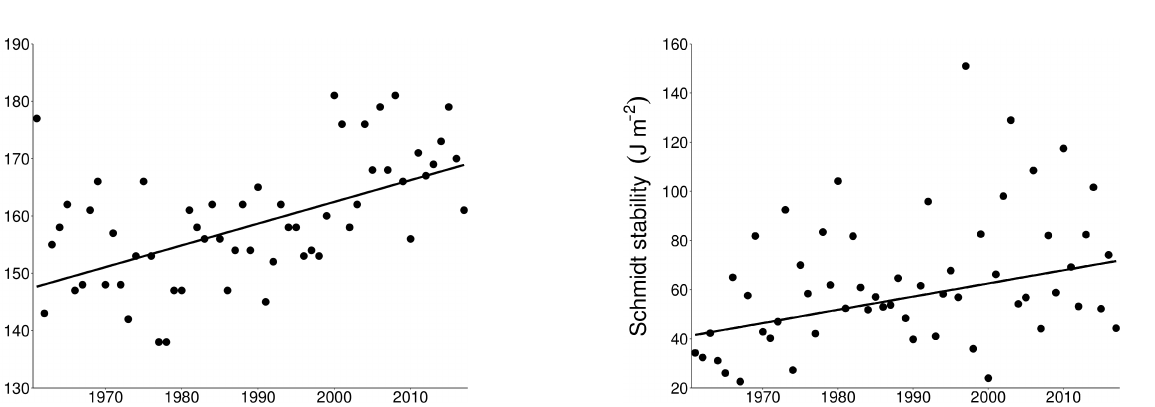
Figure 6. Growing season length calculated from simulated wa- ter temperature between 1961 and 2017 (Sen’s slope: 3.793d per decade, p < 0.001).